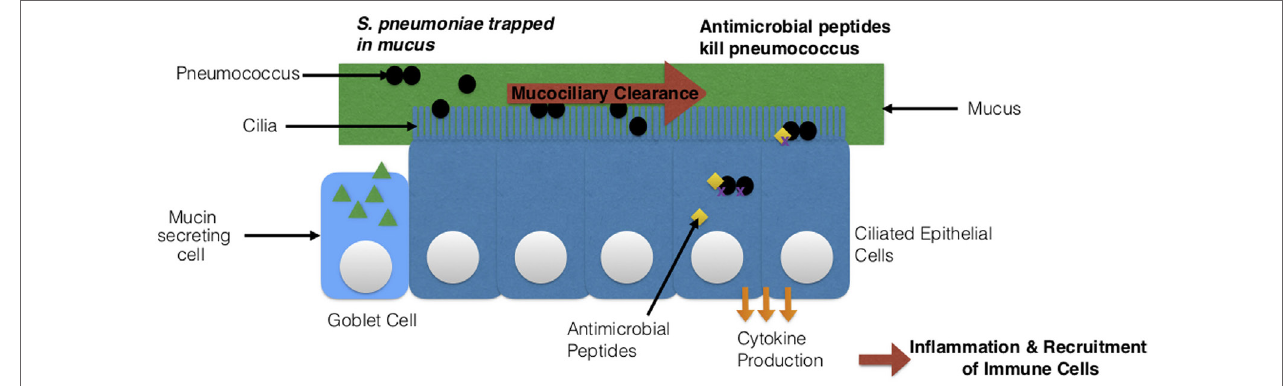
FigURe 8 | Streptococcus pneumoniae’s interaction with host epithelial cells. Two types of epithelial cells are depicted: goblet cells and ciliated epithelial cells. The cilia on the epithelial cells together with the mucus produced by goblet cells clear the pathogen via mucociliary clearance. Epithelial cells can also secrete antimicrobial peptides that directly kill S. pneumoniae or produce cytokines, which leads to a state of inflammation and the recruitment of immune